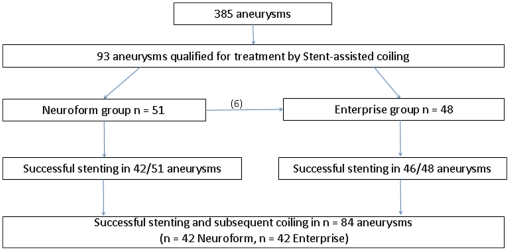
Flow chart of aneurysms treated by stent-assisted coiling.